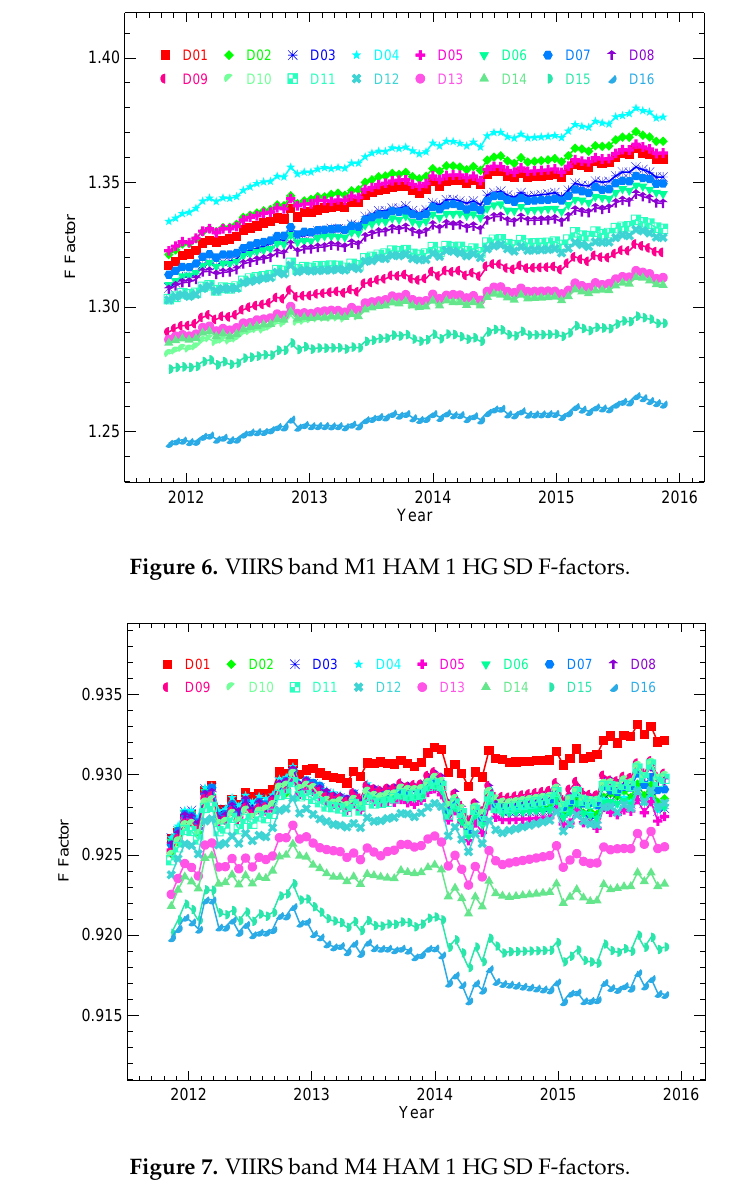
Figure 8. VIIRS band M1 detector-averaged SD F-factors. The detector-averaged F-factors for all RSB with high-gain status and HAM 1 are displayed in Figure 9. The F-factors for non-SWIR bands are normalized at the first measurement. The SWIR bands were normalized on 20 January 2012 when the temperature of the S/MWIR FPA started to be controlled. The SWIR bands were not stable and usable before 20 January 2012. The F-factors shown